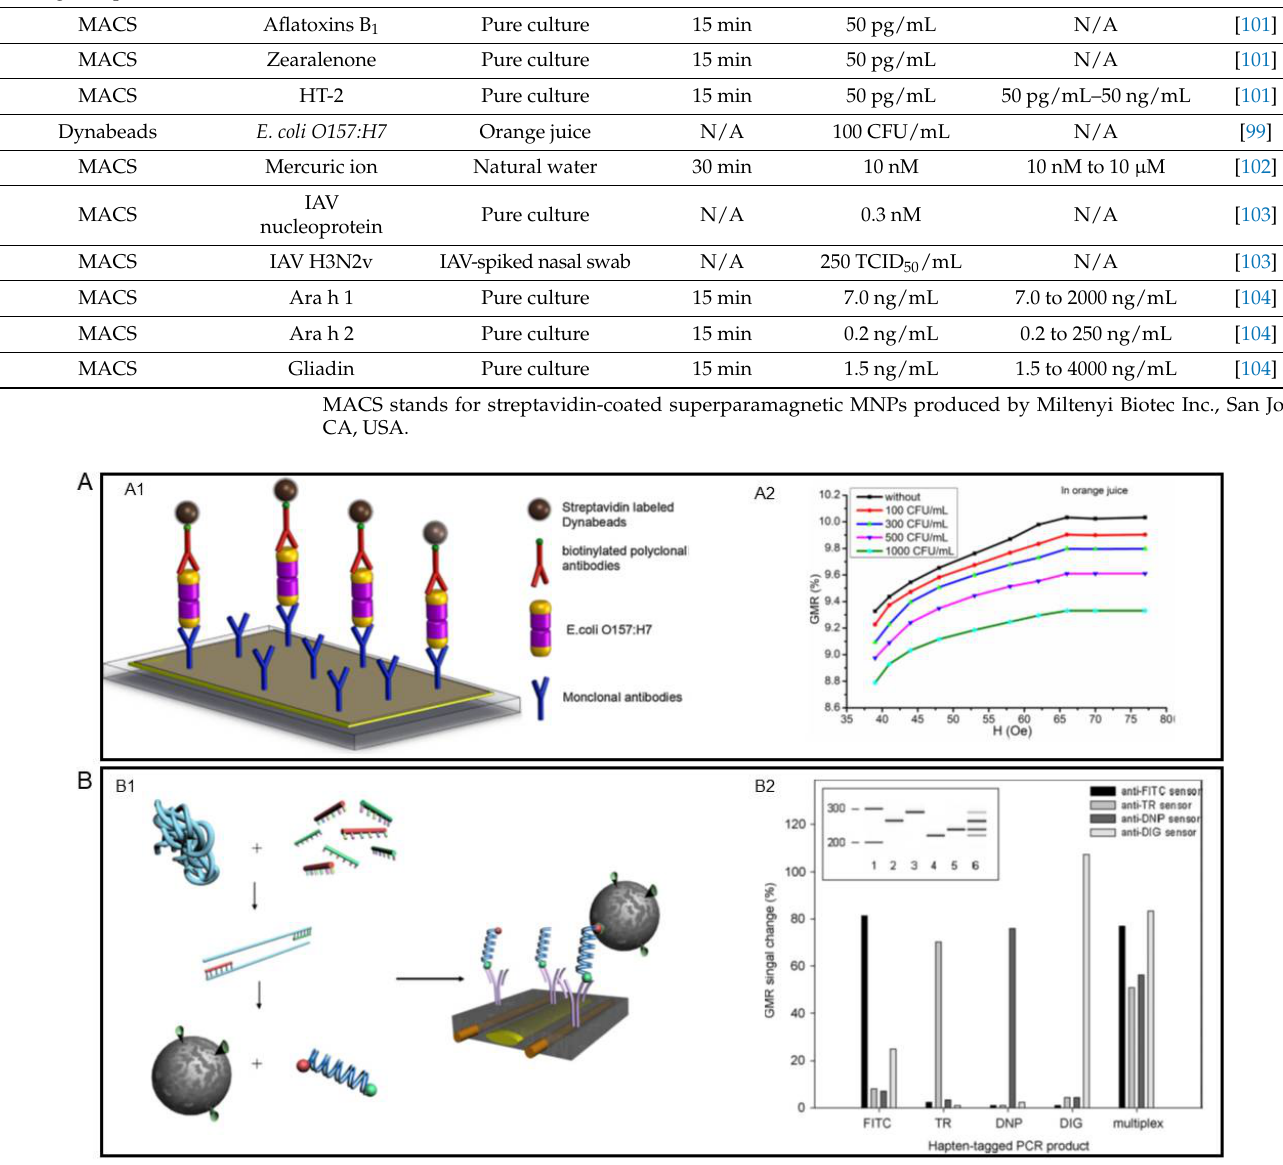
Figure 6. ( A , A1 ) Schematic view of the sandwich assay for E. coli O157H: H7 . ( A2 ) The MR curves